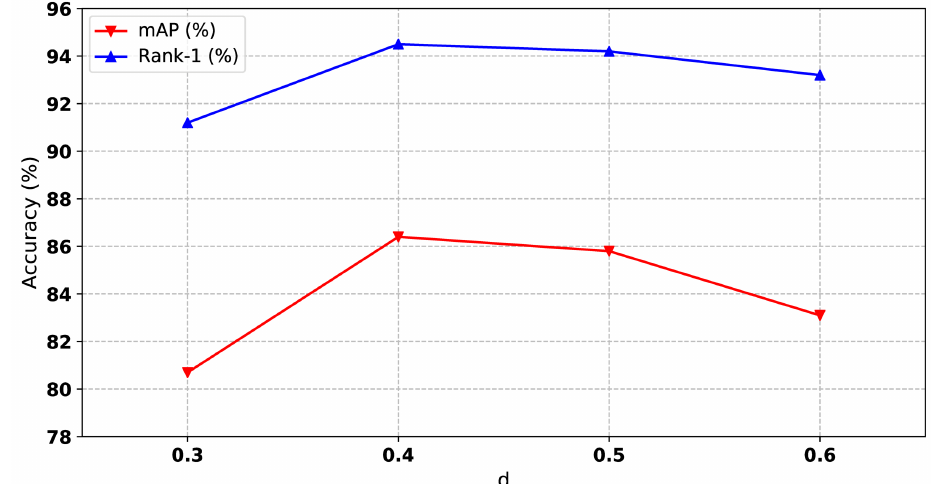
Figure 7. Performances of our method with different of d , where d represents the maximum distance between two samples in DBSCAN algorithm.